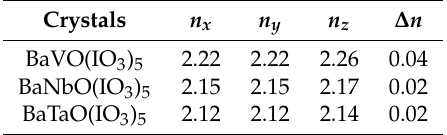
Table 3. Refractive index n and birefringence ∆ n of BaMO(IO 3 ) 5 .